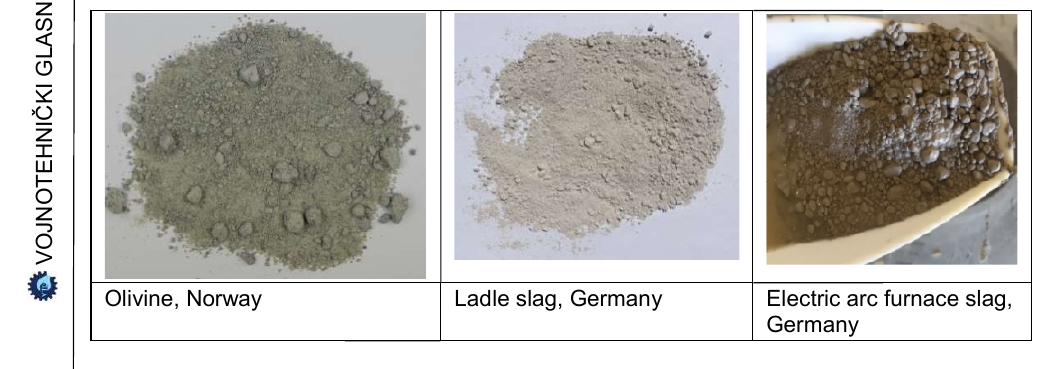
Figure 1 Рис. 1 – Используемые образцы в